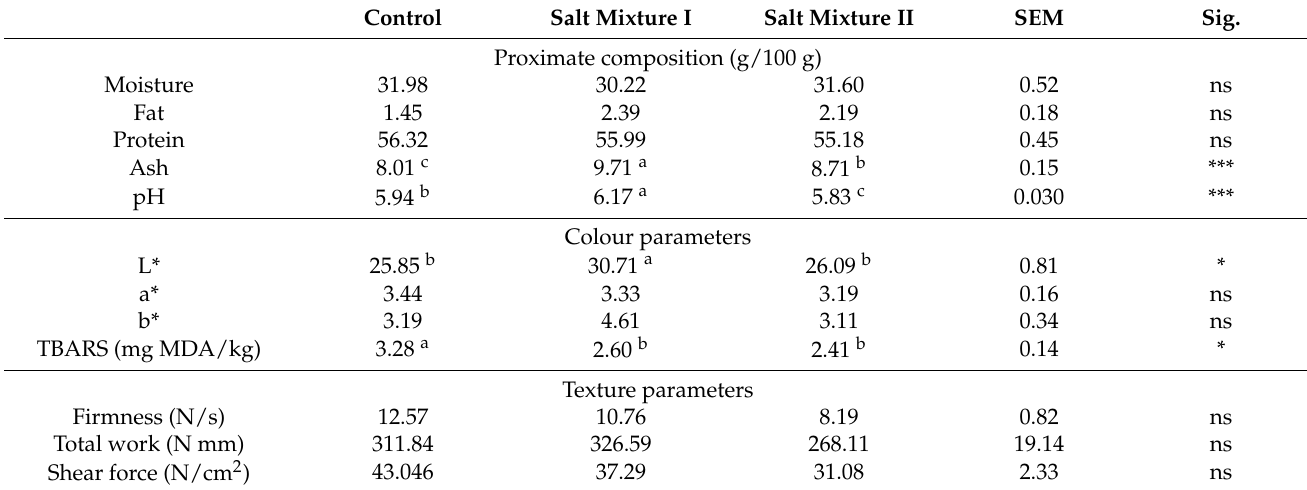
Table 1. Effect of NaCl replacement by other chloride salts on chemical composition and physicochemical parameters of dry-cured deer